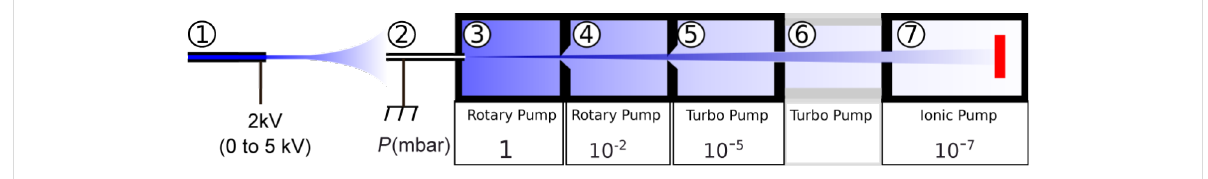
Figure 1: Scheme of the commercial ESI setup [33] (1 to 5) connected to the UHV chamber (7), i.e., sample preparation chamber. The additional vacuum chamber (6) was added to further enhance the performance of the deposition